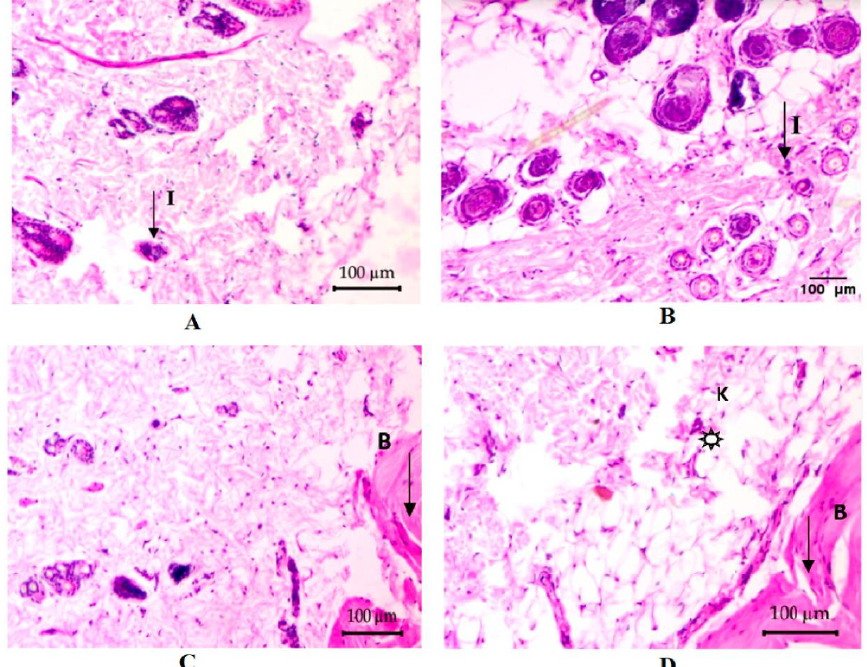
Figure 7. Representative photomicrographs of the rat skin tissues in the control, drug-free chitosan- coated naringenin and chitosan-coated naringenin (CNNE) treated groups of abrasion model in albino Wistar rats. ( A ) Wound area before the treatment at day 0, ( B ) control group at day 14, ( C ) drug-free chitosan-coated naringenin formulation treated group at day 14, and ( D ) CNNE treated group at day 14. (I: inflammatory cells; B: blood vessels; K: keratinization; Star icon: granulated tissue). Reproduced with permission from Akrawi et al., “Development and Optimization of Naringenin-Loaded Chitosan-Coated Nanoemulsion for Topical Therapy in Wound Healing”, published by MDPI, 2020 [72].